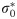
ABM simulations match the limited clonal dominance development for the monoclonal K562 cell line.A–B Maximum Likelihood estimator (ℓ) based on clone loss (A) or Gini coefficient (B), for a range of initial division rate SDs (σ0*) and mutation SDs (σm*). C–D Clone loss (C) and clonal dominance (D) in simulations, with the parameters from the red rectangle in B, and in the experiments with monoclonal K562 cells. All simulation results are the mean of 10 runs and the results for the monoclonal K562 cells are the mean of 3 replicates, with the error bars representing the SD.